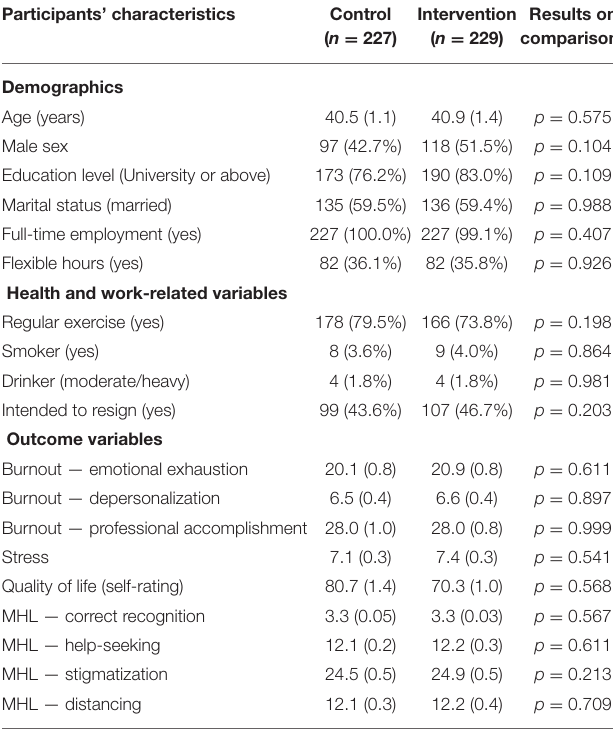
TABLE 1 | Frequency (%) or mean (s.e.) of participants’ demographic, health and work-related variables, and baseline assessment of outcome variables by groups and the results on comparisons ( N =